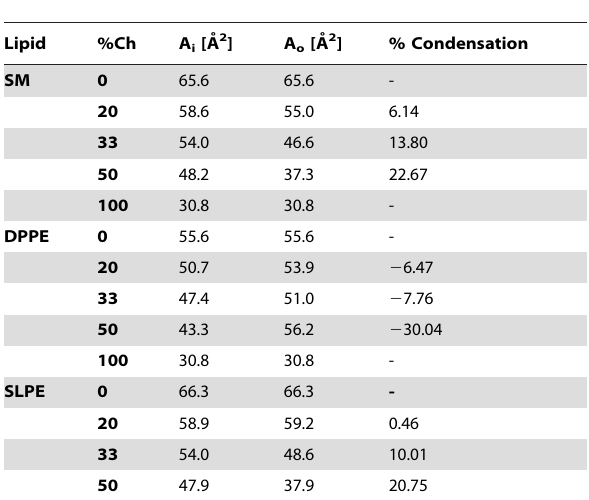
Table 2. Average molecular area and percent condensation values vs. composition of SLPE/Ch mixtures measured at a surface pressure of 3 mN/m at 4 or 37 u C.